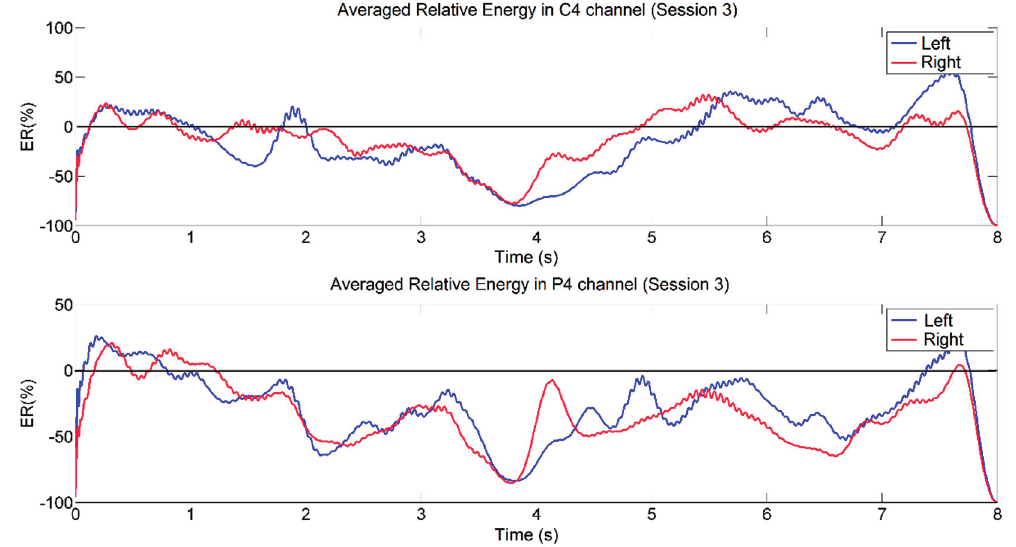
Figure 6. Relative average energy of channels C4 and P4 during S 3 ( μ